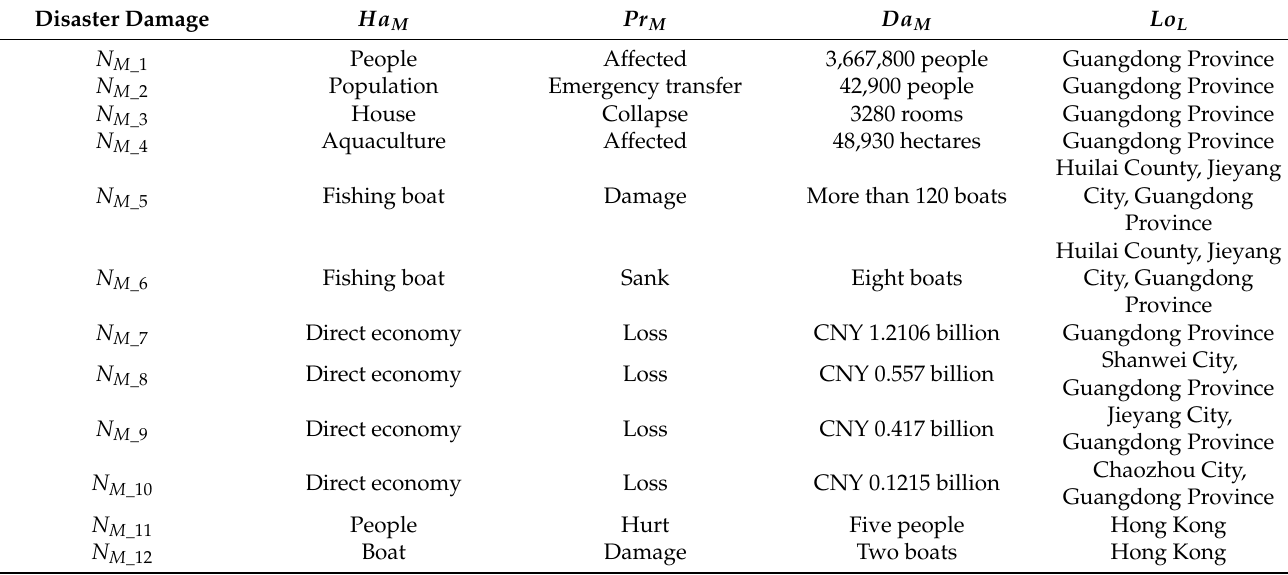
Table 9. Label information V M and V L of storm surge disaster case no.